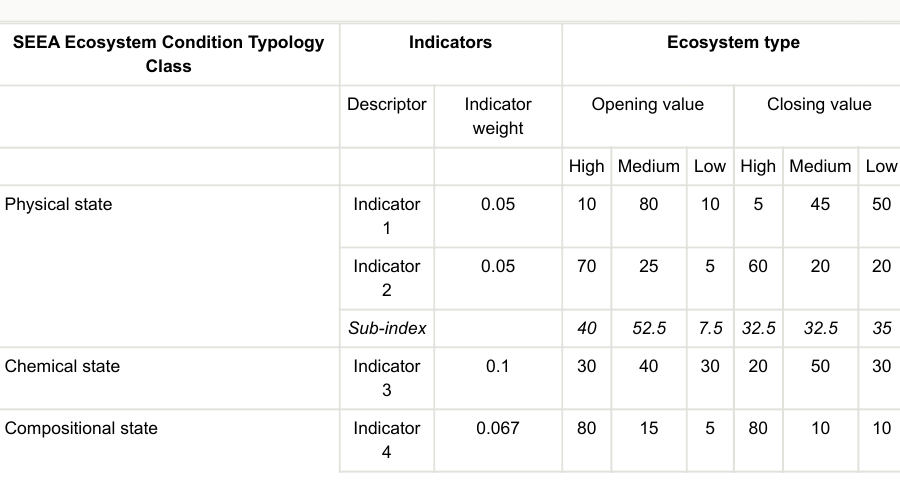
Ecosystem condition index account reported using discretised ranges (i.e. area (%) in each range of condition). (Numbers in cells are examples only and indicator weights were selected arbitrarily, but must sum to